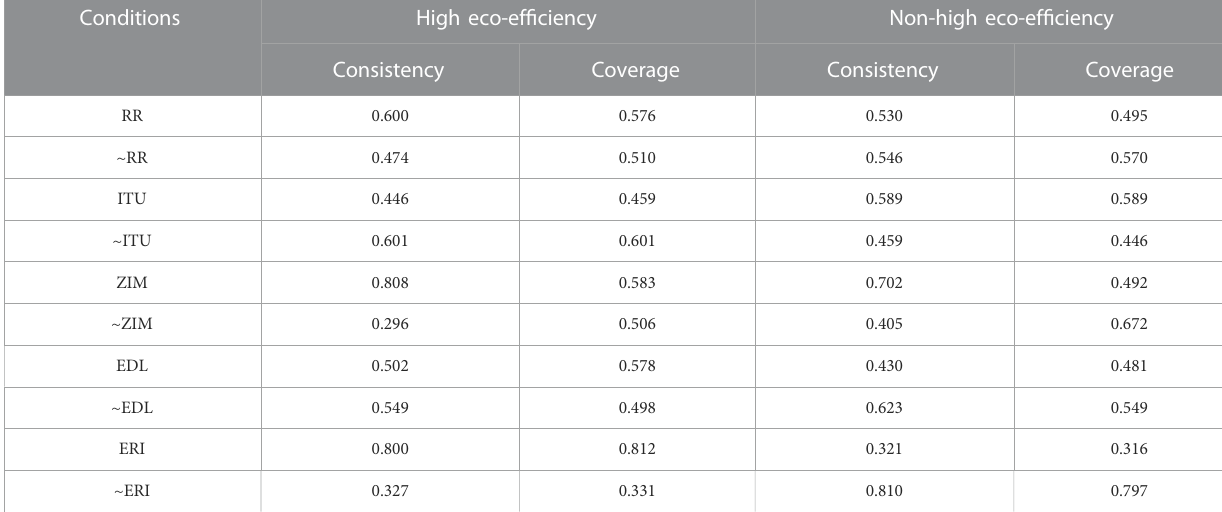
TABLE 3 Results of necessity